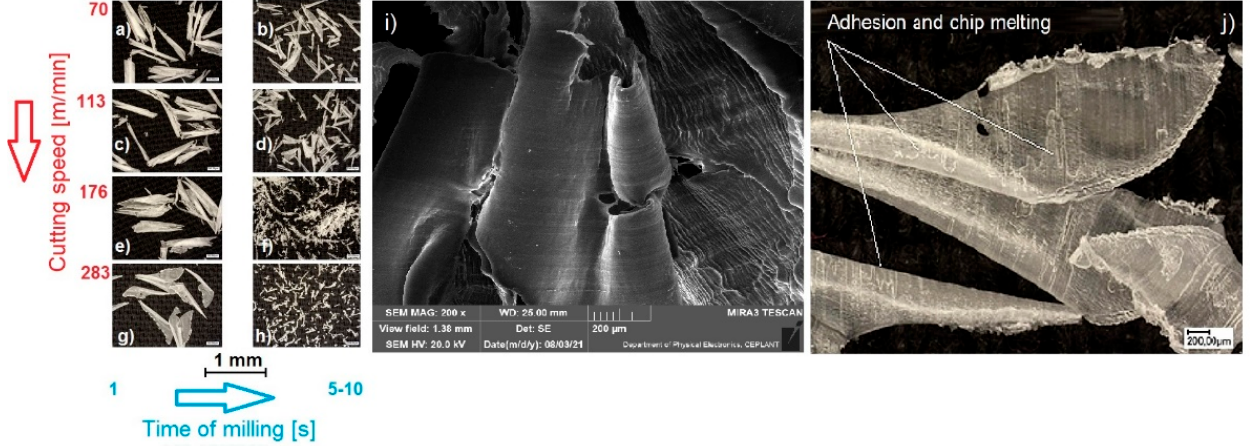
Figure 12. Morphology of chips when milling UHMWPE. ( a )–( h ) the effect of cutting speed, ( i ) the high plastic deformation of the chip, ( j ) traces of chip melting and high adhesion of UHMWPE to the cutting tool.